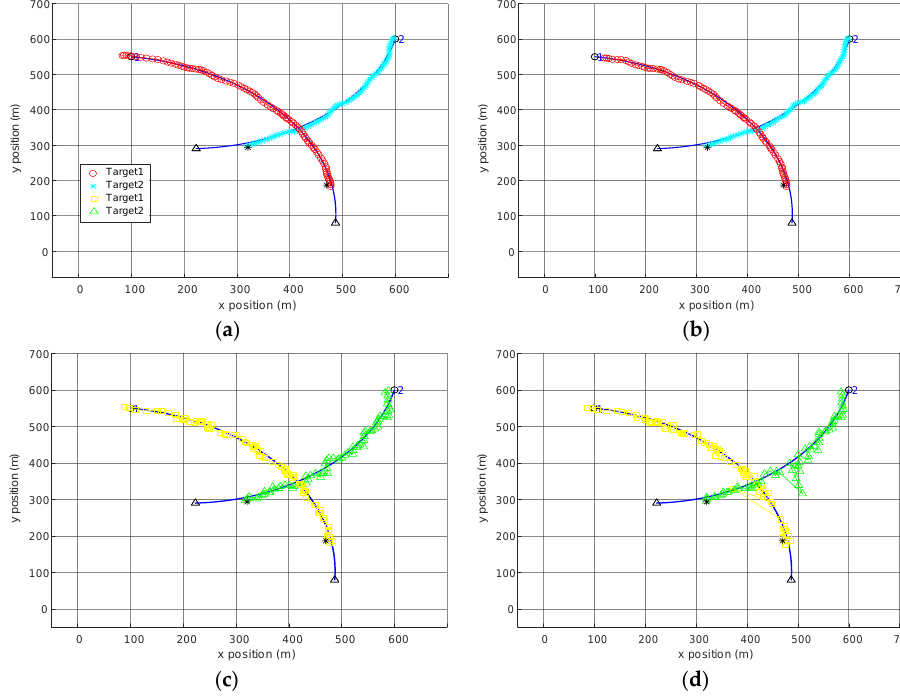
Figure 5. ( a ) The trajectory estimates of AEK-VB-TPHD until time 85. ( b ) The trajectory estimates of AUK-VB-TPHD until time 85. ( c ) The trajectory estimates of AEK-tag-VB-PHD until time 85. ( d ) The trajectory estimates of AUK-tag-VB-PHD until time 85. The trajectory of the true target is marked with blue line segments in the period, the circle represents the starting point of the track, the triangle represents the end point of the trajectory, different trajectories are marked with different color styles ( L =5) and the black asterisk represents the measurement at the current time.